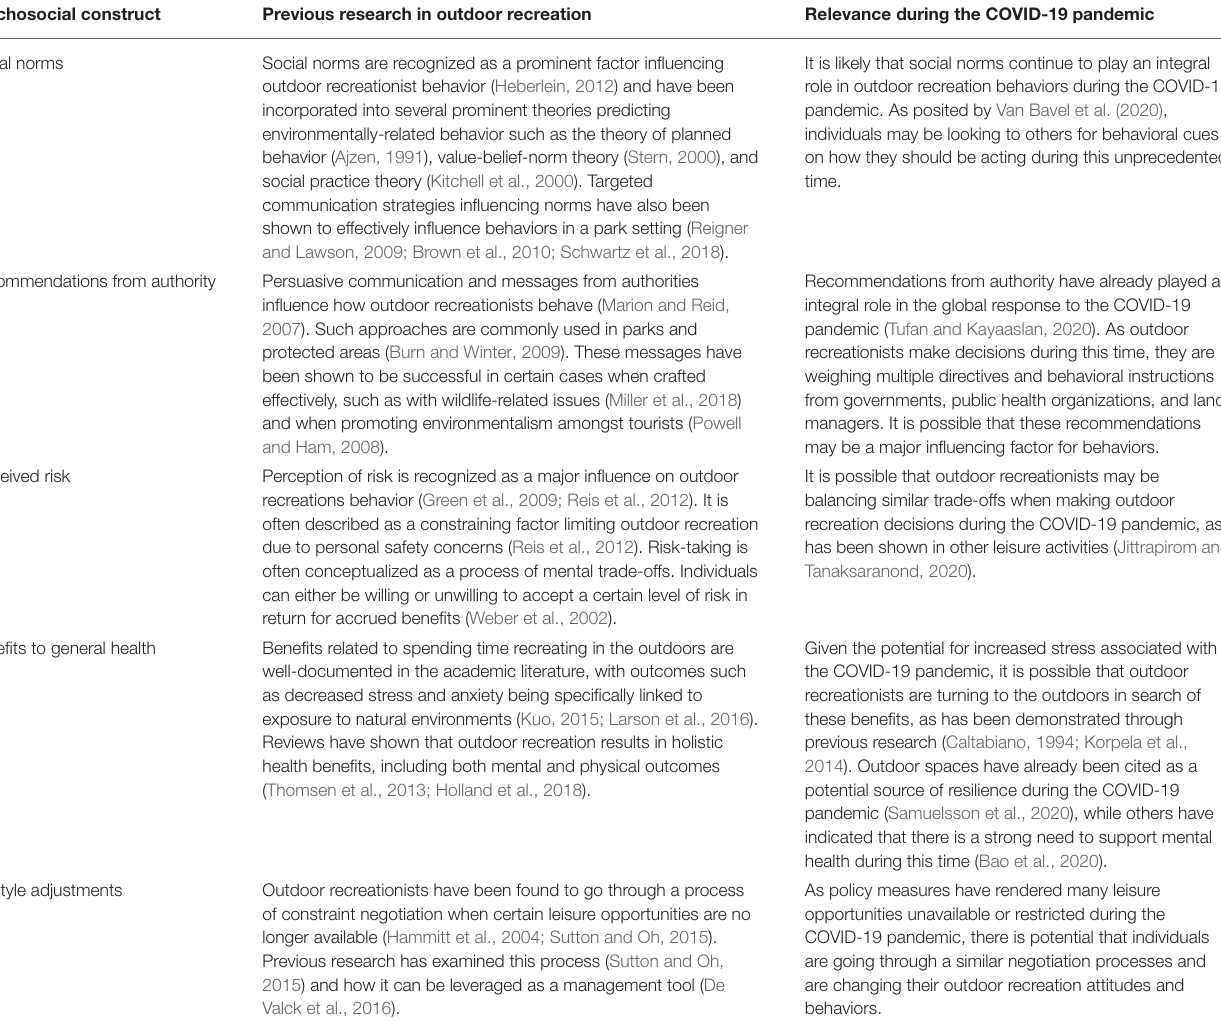
TABLE 1 | Previous literature on focal psychosocial